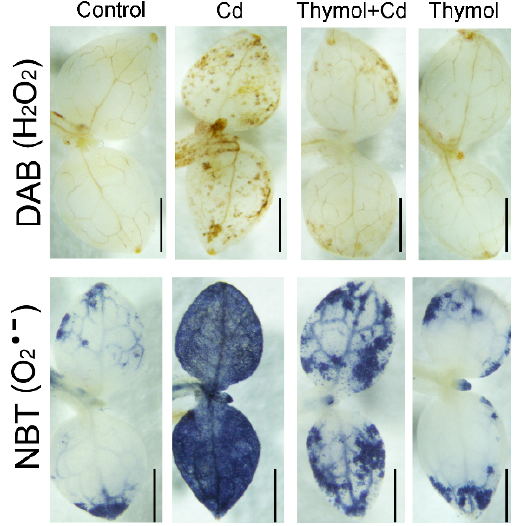
Figure 3. The effect of thymol on the generation H 2 O 2 and O 2• ¯ in the leaves of tobacco seedlings under Cd stress. The roots of seedlings were treated with water (control), CdCl 2 (20 μ M), CdCl 2 (20 μ M) + thymol (100 μ M), and thymol (100 μ M) for 72 h. After treatment, the seedlings were excised at the base of the stem and supplied DAB or NBT for 6 h through the cut stems. Then the leaves were decolorized with ethanol and photographed with a stereoscopic microscope. Bar = 1 mm.